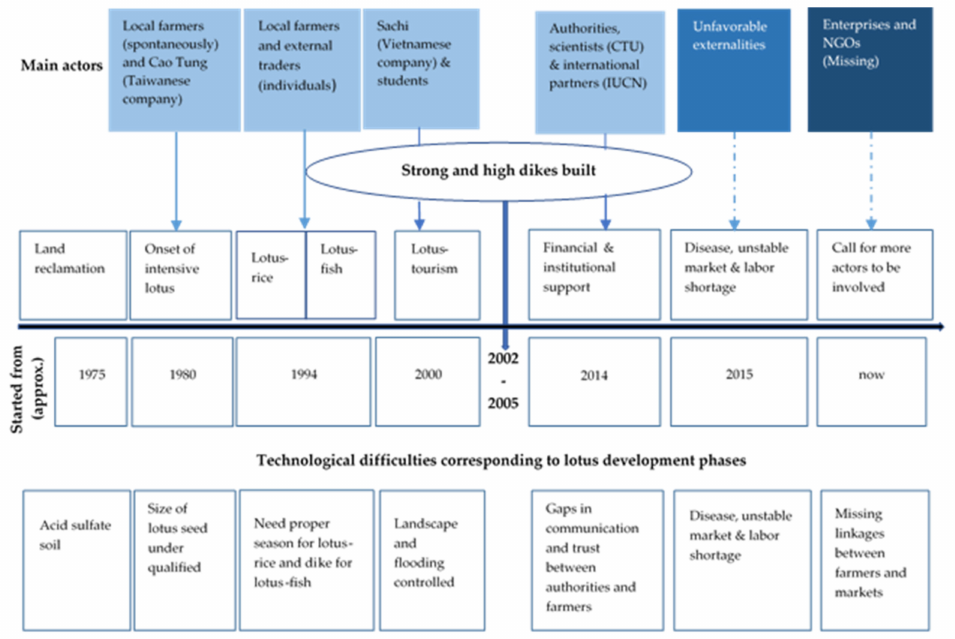
Figure 1. Lotus Cultivation: Timeline of Technology Emergence and Involvement of Relevant